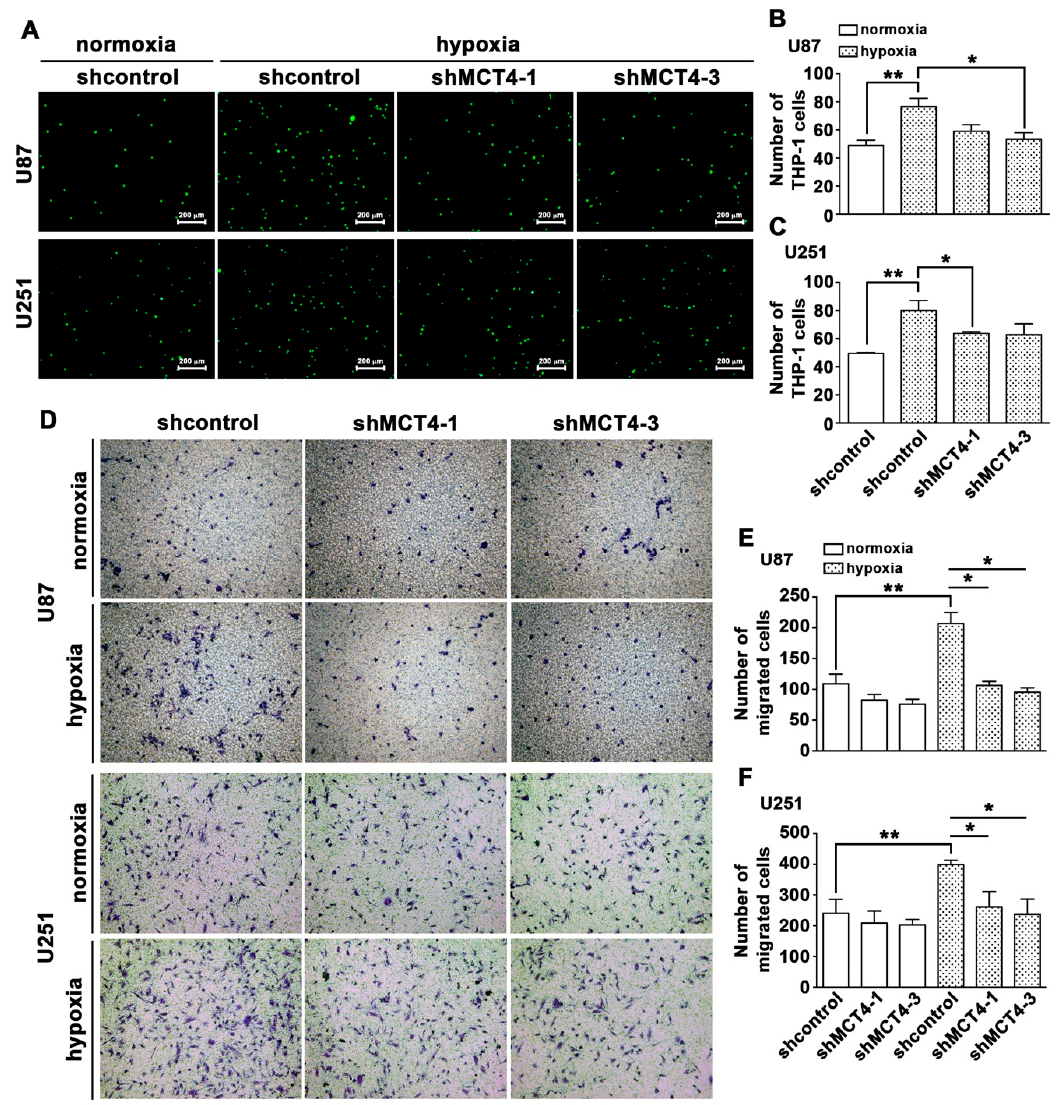
Figure 3. Downregulation of MCT4 attenuates hypoxia-enhanced monocyte adhesion and GBM migration. ( A ) U87 and U251 cells were transfected with the control or MCT4 shRNA for 24 h and were exposed to hypoxic conditions (1% O 2 ) for 24 h. BCECF-AM-labeled-THP-1 was added to U87 and U251 cells for 40 min, and then the adherence of THP-1 was measured by fluorescence microscopy. Quantification of monocyte adhesion abilities on GBM U87 ( B ) or U251 ( C ) cells. ( D ) GBM U87 and U251 cells were transfected with the control or MCT4 shRNA for 24 h and were exposed to hypoxic conditions (1% O 2 ) for 24 h; migration activities were measured by a transwell assay and were visualized using a digital camera. Quantification of U87 ( E ) and U251 ( F ) cell migration by counting the number of cells that migrated to the underside of the filter. Two-way ANOVA with a post-hoc Bonferroni multiple was used to examine the significance of the mean. * p < 0.05 compared with the hypoxia control (sh) group. ** p < 0.01 compared with the normoxia control (shcontrol)